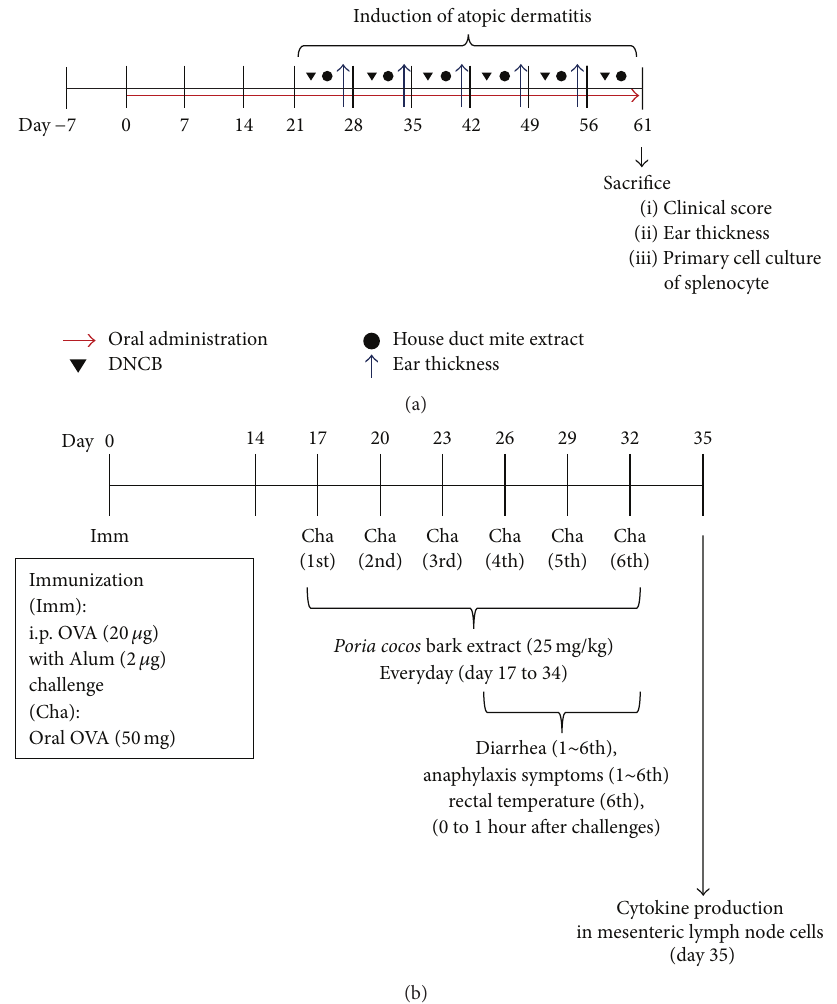
Figure 1: Experimental designs for inductions of atopic dermatitis and food allergy. (a) Five-week-old female BALB/c mice were divided into na¨ıve ( 𝑛 = 7 ), sham ( 𝑛 = 12 ), PCB ( 𝑛 = 12 ), and dexamethasone ( 𝑛 = 8 ) groups. 25 mg/kg of PCB extract was orally administrated from day 0 to 61. For induction of atopic dermatitis, each 1% DNCB and 10mg/mL of HDM extract was applied to each ear once a week from day 21 (total six times). (b) Six-week-old female BALB/c mice were divided into na¨ıve ( 𝑛 = 5 ), sham ( 𝑛 = 9 ), PCB ( 𝑛 = 9 ), and dexamethasone ( 𝑛 = 5 ) groups. To induce food allergies, mice were immunized with 20 𝜇 g OVA and 2 mg Imject Alum by intraperitoneal (i.p.) injection on day 0. From day 17, mice were orally challenged with 50 mg OVA in saline every 3 days, for a total of six times. Next, 25 mg/kg PCB extract was administered orally daily from day 17 to